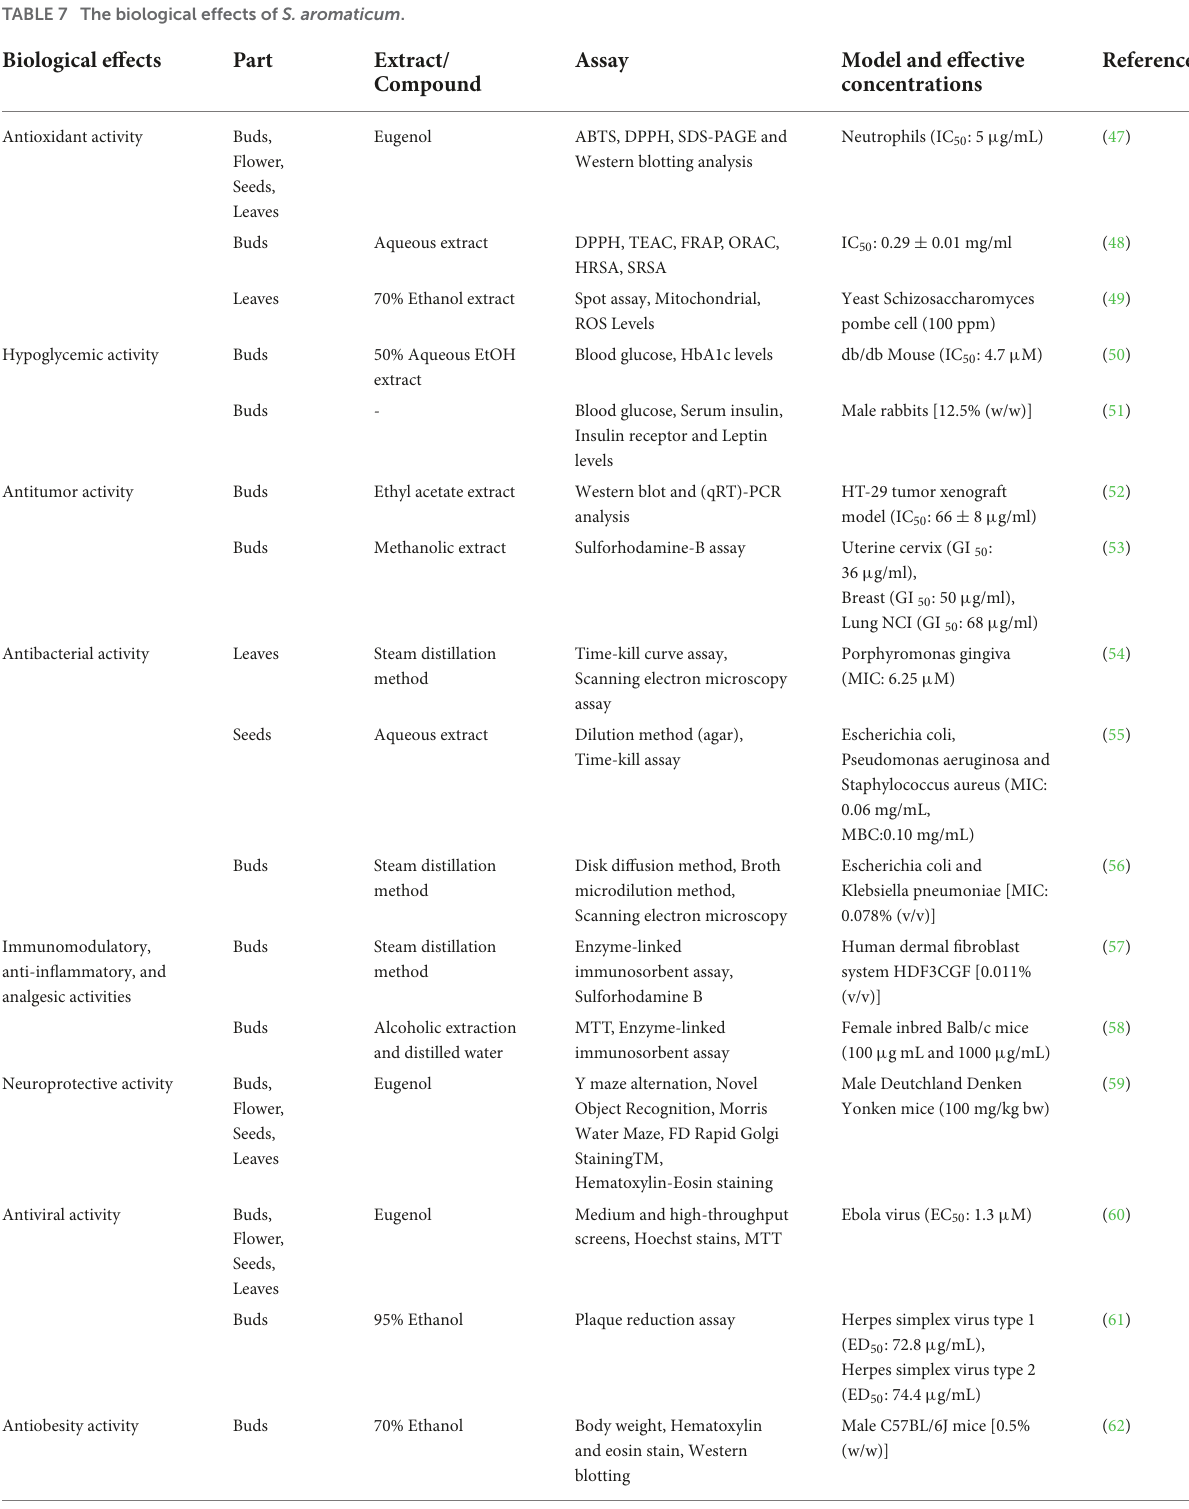
TABLE 7 The biological effects of S. aromaticum